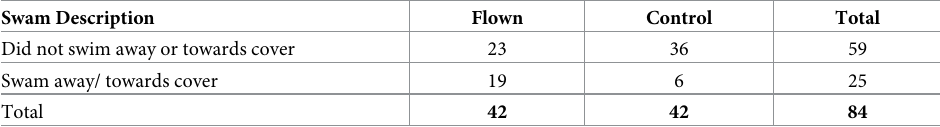
Table 4. Summary statistics for the binary response of birds swimming away or towards cover during the UAV flight on a whole wetland perspective basis. We conducted a total of 42 flights during the spring and early summer